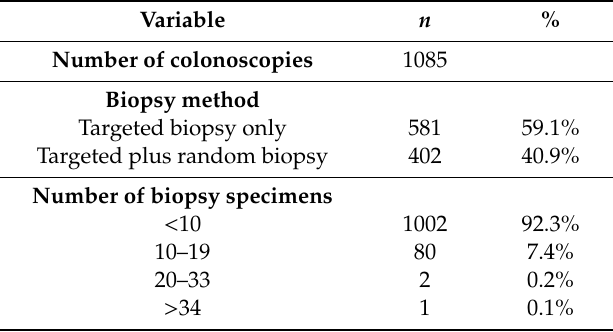
Figure 4. The fate of neoplasia detected at RCT. Abbreviation: bx- biopsy; CS- colonoscopy; ER- endoscopic removal; LGD- low-grade dysplasia. Table 4. Real-life method of surveillance.